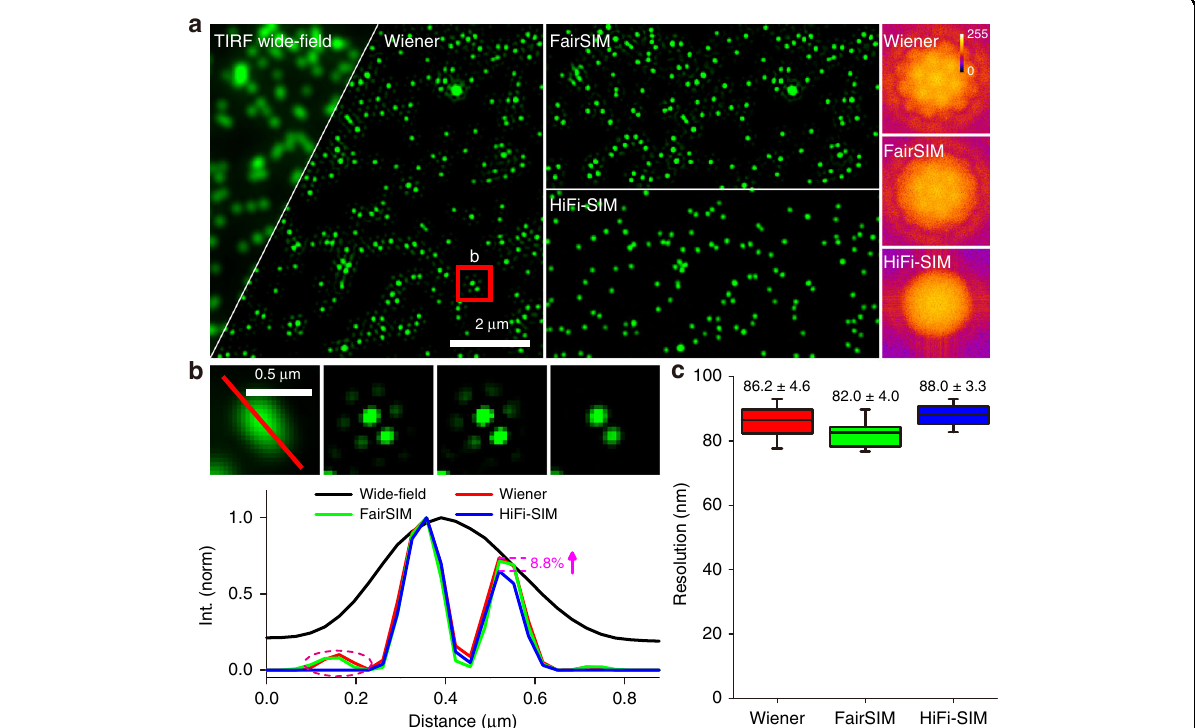
Fig. 2 Experimental characterization of the correlation between artifacts and abnormal features of reconstructed spectrum. a SR images of 100 nm fl uorescent microspheres collected from our home-built TIRF-SIM setup were reconstructed using the traditional Wiener-SIM we implemented, fairSIM, and HiFi-SIM, and the corresponding reconstructed spectrum is shown on the right. Note that the reconstructed spectrum of traditional Wiener-SIM and fairSIM both show obvious patchy features, and the real microspheres in the SR images contain obvious sidelobe artifacts. b Magni fi ed images of the red-box region in a , and the line pro fi les along the microspheres in b show diminishing sidelobe artifacts in HiFi-SIM. c Full-width half-maxima (FWHMs) of the fl uorescence pro fi les of 10 microspheres in the reconstruction images of traditional Wiener-SIM, fairSIM, and